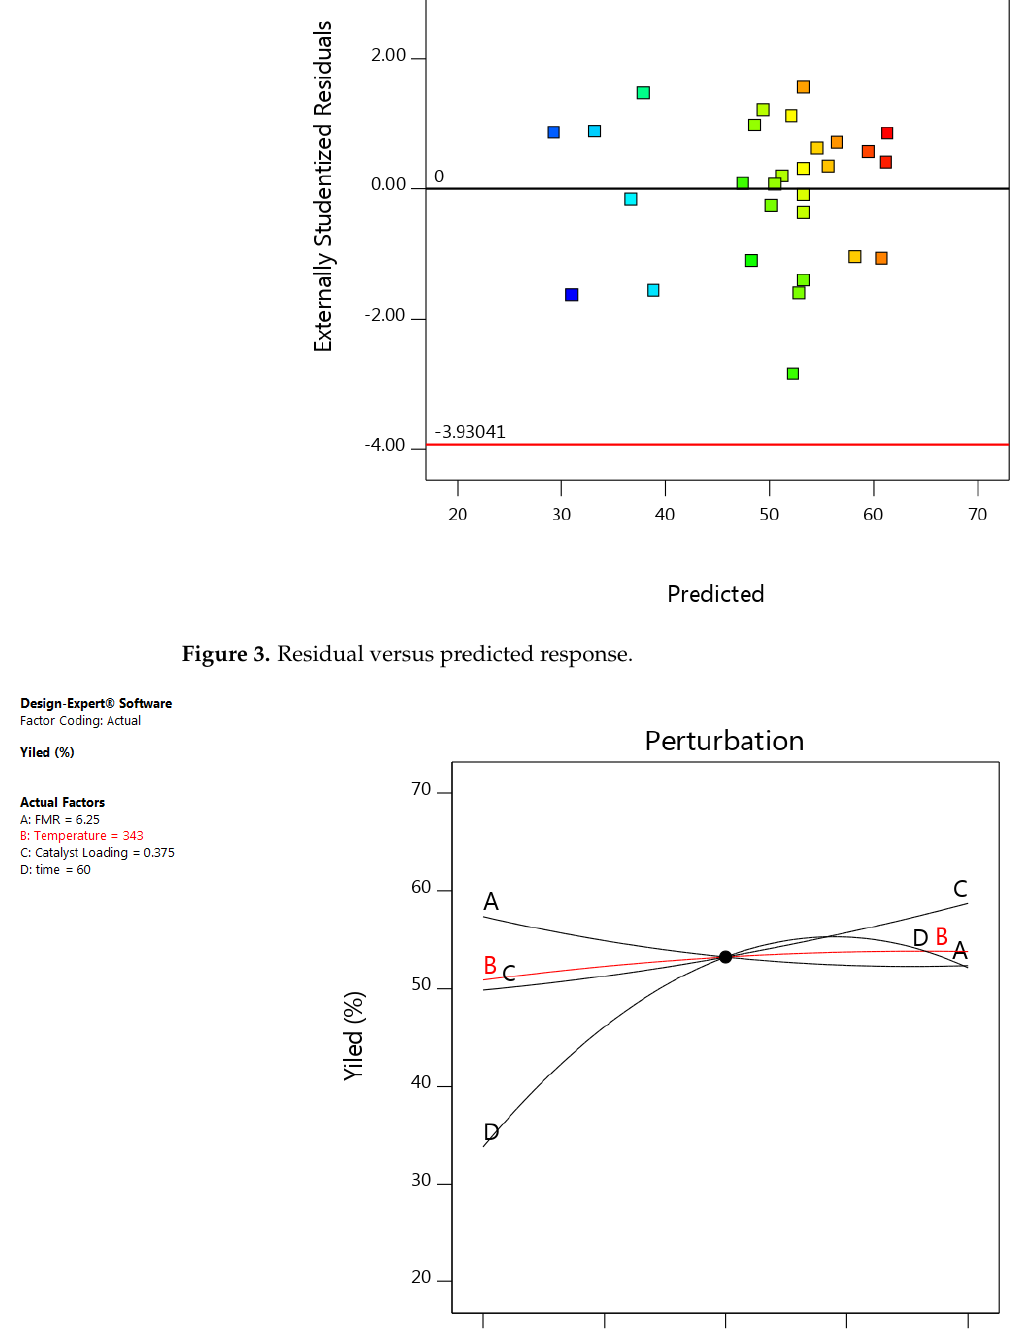
Figure 4. The perturbation plot represents the effect of each variable on the reaction response.